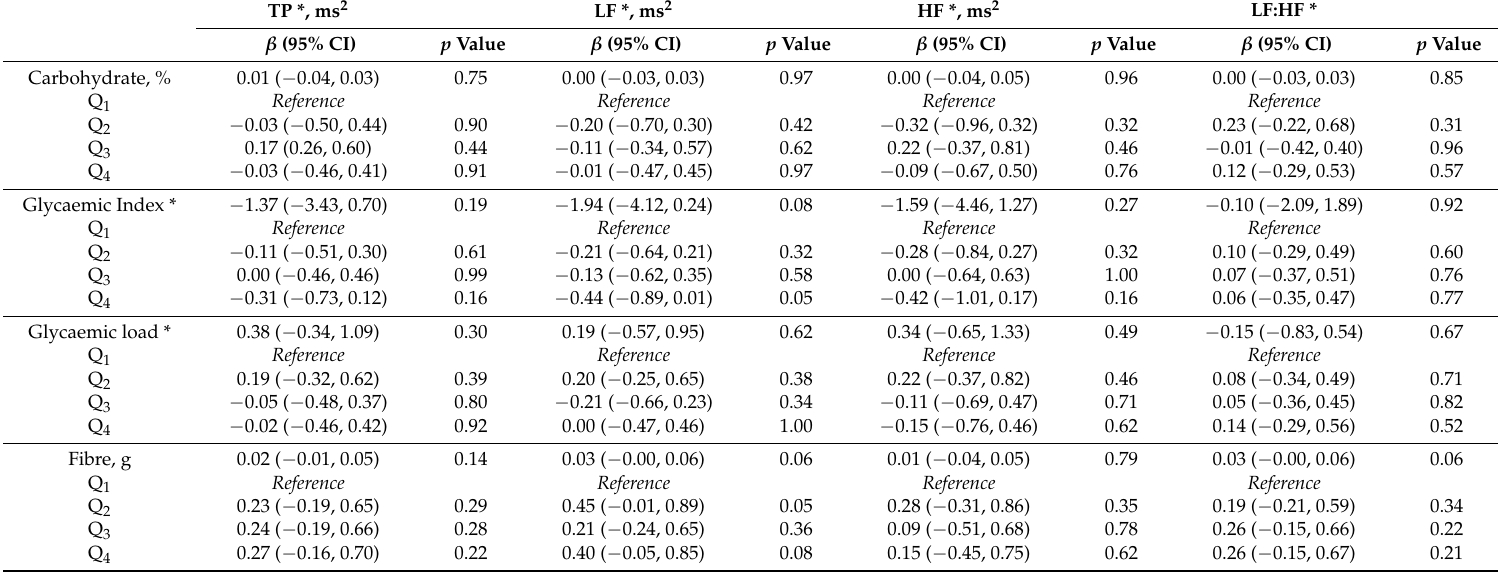
Table 3. Associations between maternal carbohydrate content and quality with newborn heart rate variability (autonomic cardiac